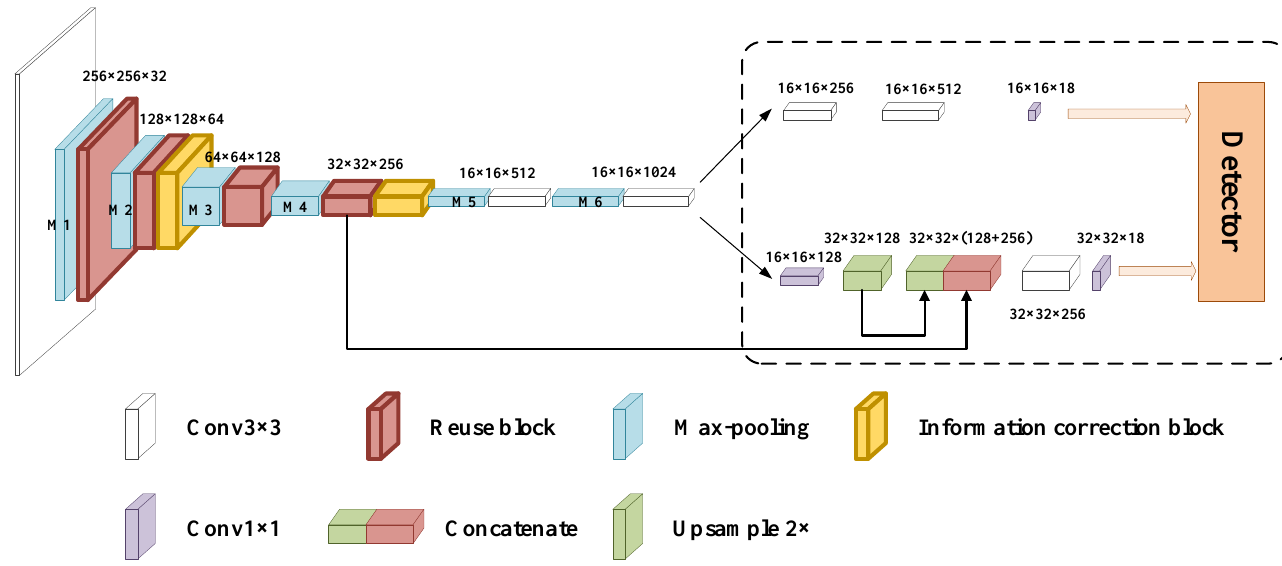
Figure 2. The framework of the lightweight detection model